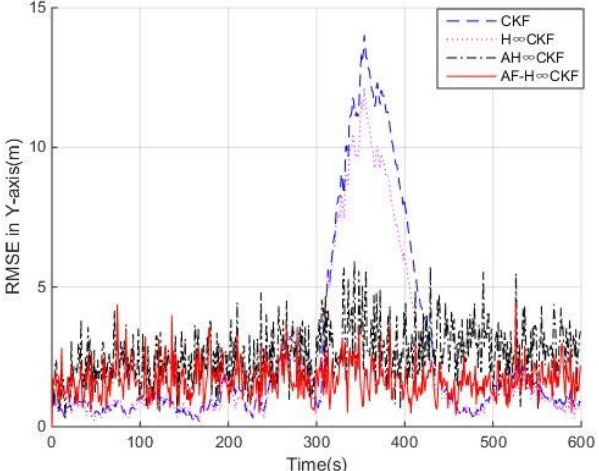
Figure 7. RMSE in the Y-axis in Case 2.